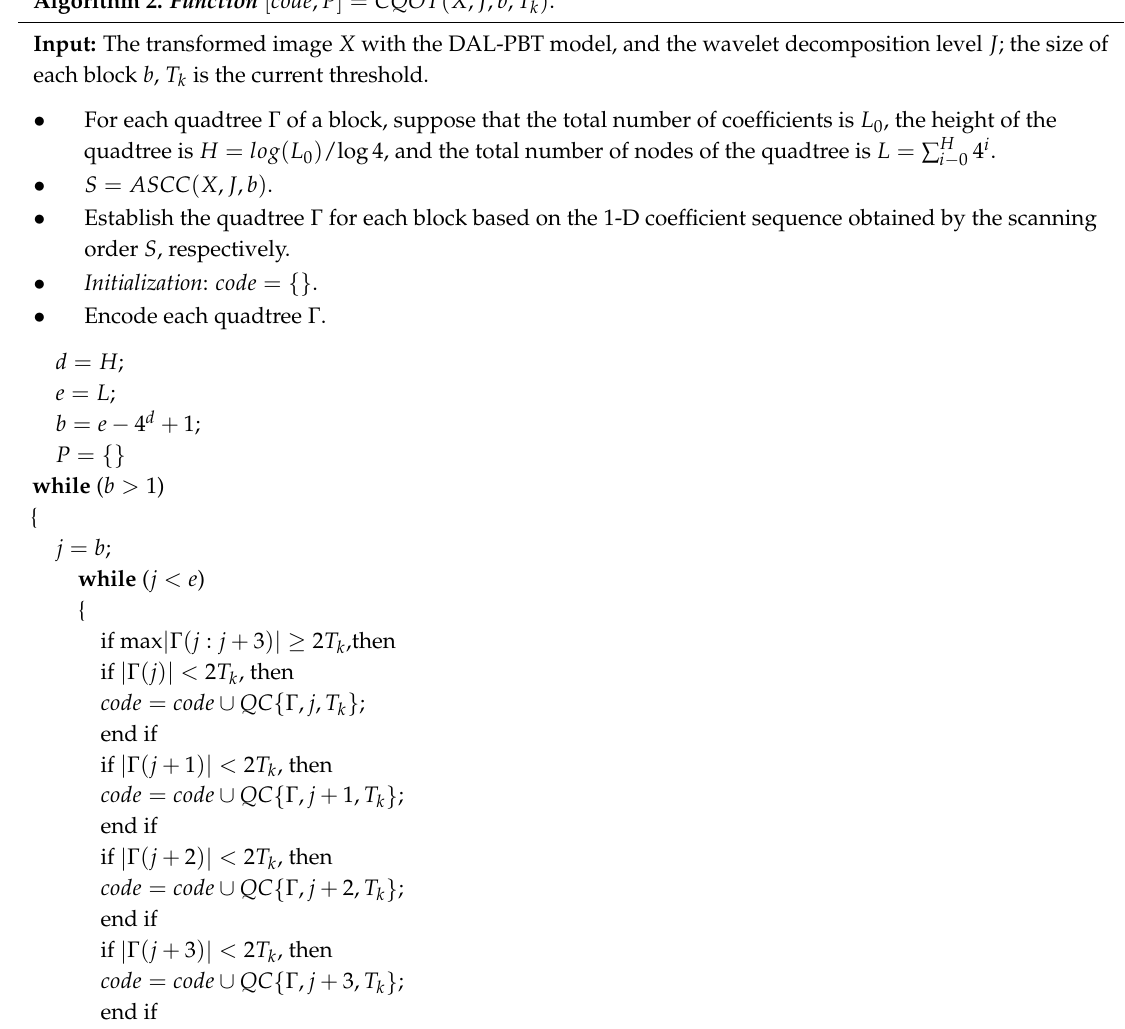
Algorithm 2. Function [ code , P ] = CQOT ( X , J , b , T k )